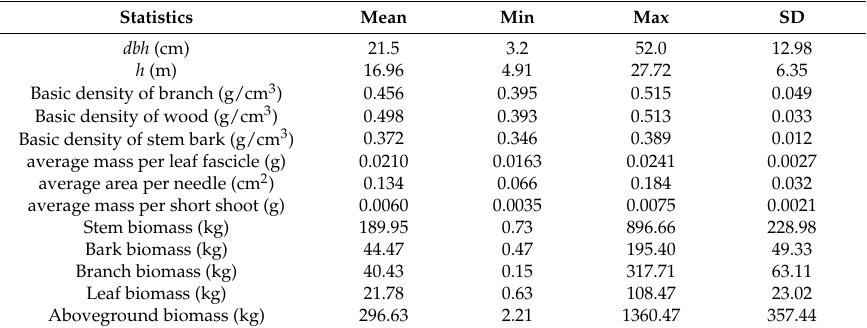
Table 1. Descriptive statistics of sampled trees for biomass equations